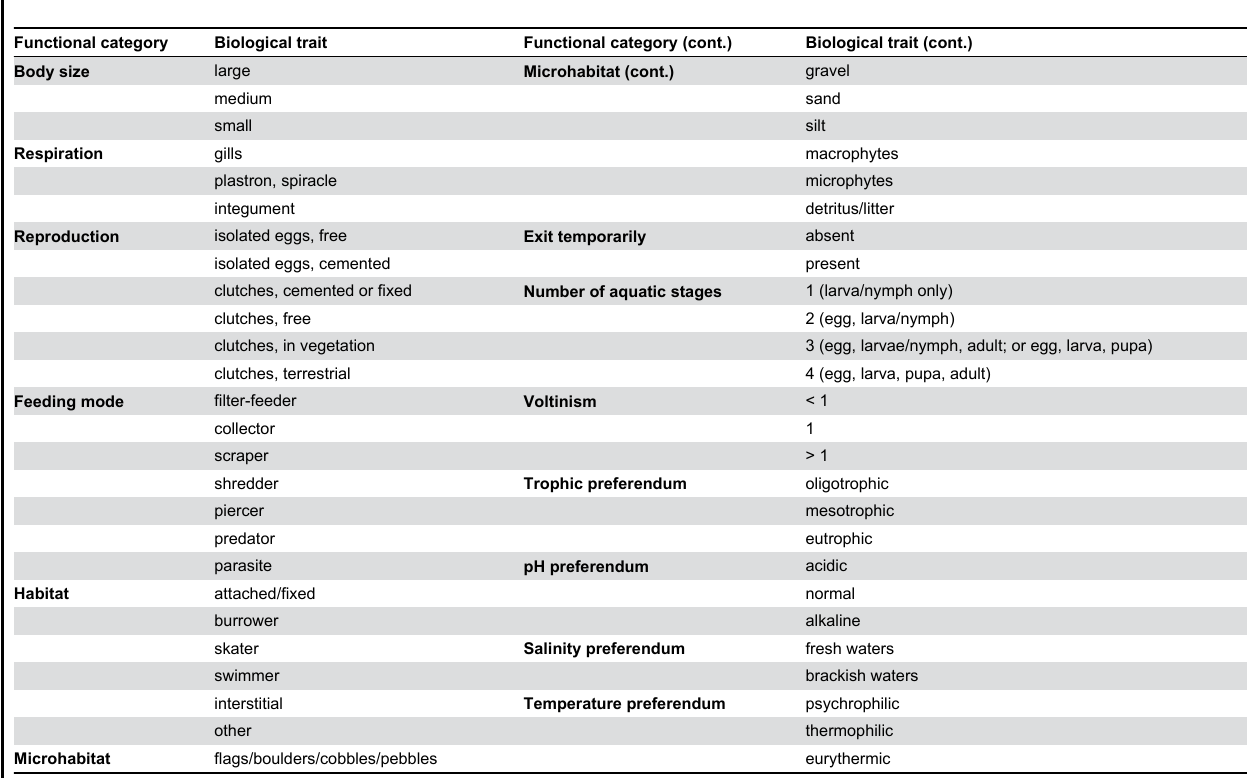
Table 2. Functional categories and biological traits considered in this study.